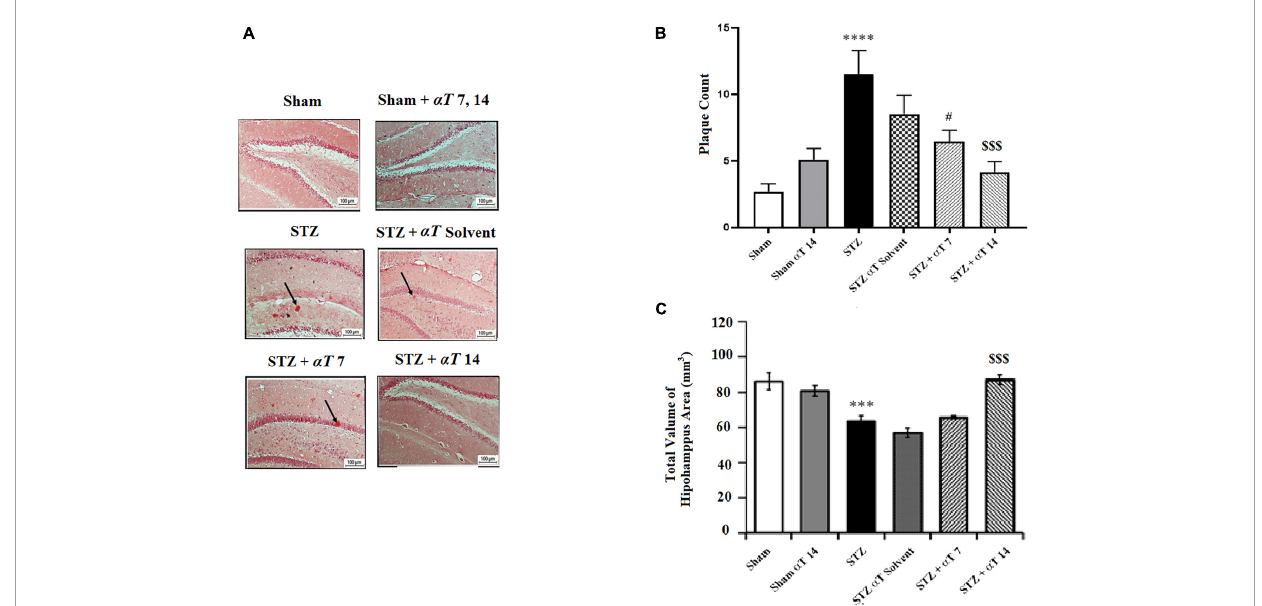
FIGURE6 The number of β -Amyloid plaques and measurement of neuronal cell density in the hippocampal areas. (A) Congo red staining in the hippocampus area for sham, sham + α T 7, 14), STZ, STZ + solvent, STZ + α T, 7 and STZ + α T 14. Black arrows show β -Amyloid plaques. (B) Results of congo red staining for β -Amyloid plaques ( ∗∗∗∗ P < 0.0000 STZ in comparison with sham; # P < 0.05 and $$$ P < 0.001 STZ + α -Tocopherol 7 and STZ + α -Tocopherol 14 in comparison with STZ, respectively). (C) The number of Nissl-stained neurons in hippocampus areas in experiment groups. This assessment was performed 4 weeks after icv-STZ injection ( n = 5 in each group) ( ∗∗∗ P < 0.001, STZ in comparison with sham; $$$ P < 0.001; STZ + α -Tocopherol 14 in comparison with STZ) ( n = 5). All graphs were plotted as mean ±